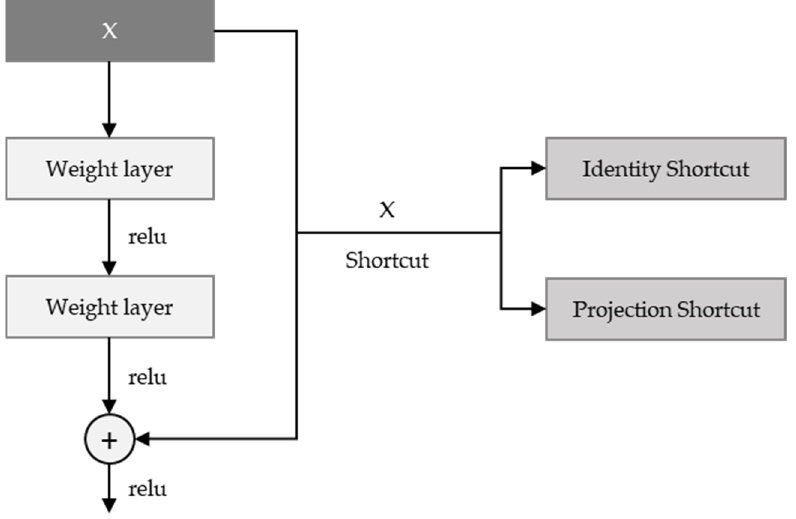
Figure 3. Residual learning: a building block.